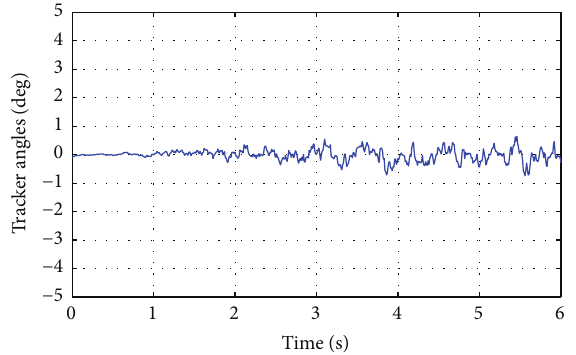
Figure 20: Error for vehicle B